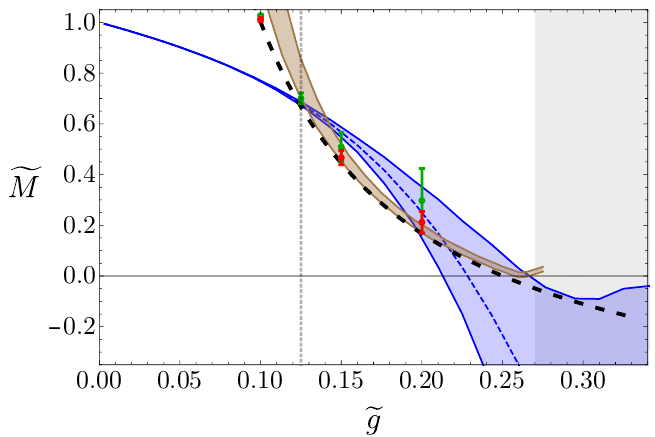
Figure 12 . Comparison between 2 M